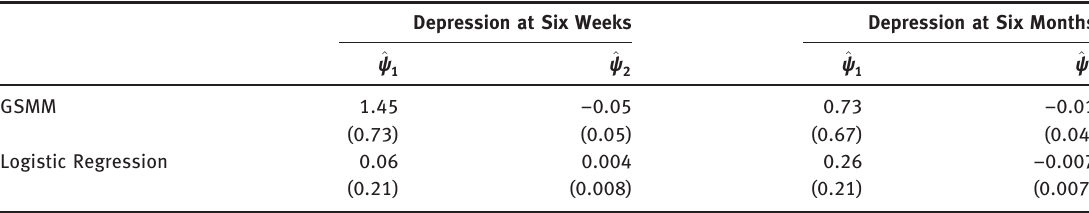
Table 4: 4 Empirical analysis. Estimates are presented for the log-odds ratio causal effect parameter ψ 1 and post-treatment effect modification ψ 2 under 2 different approaches: (i) two-stage G-estimation; and (ii) logistic regression. All method condition on the same set of pretreatment covariates. Standard errors are in parentheses.